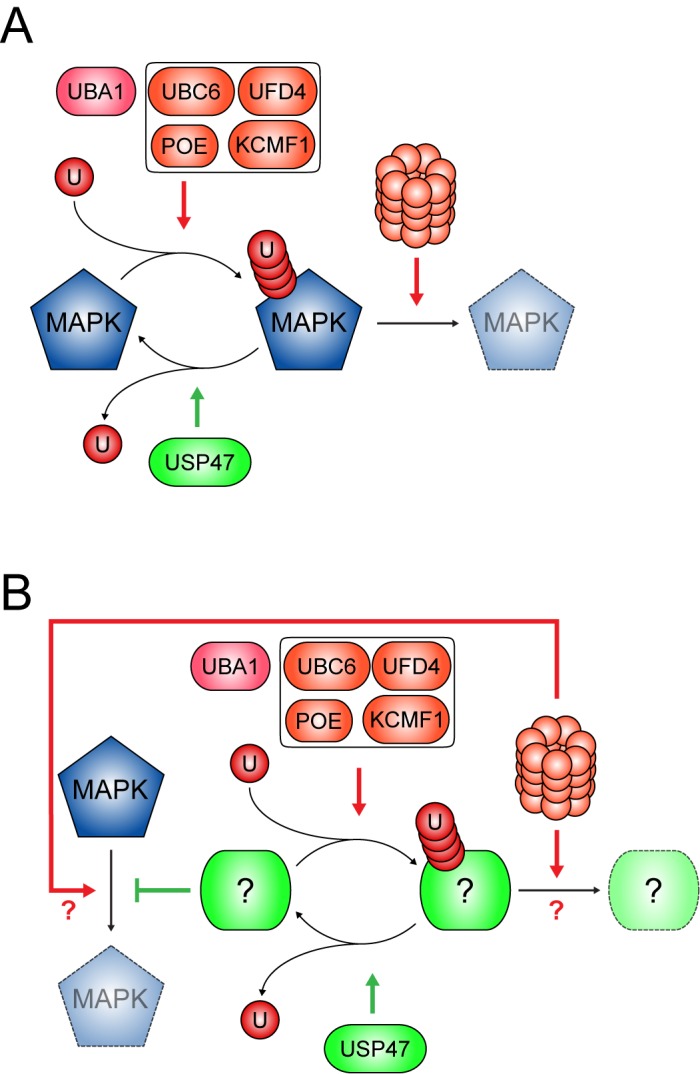
Models for regulation of MAPK stability by USP47.(A) Direct ubiquitination of MAPK. In this model, UBC6, POE, UFD4, and KCMF1 would participate in the direct ubiquitination of MAPK. Ubiquitinated MAPK could then be targeted to the proteasome for degradation. In the presence of USP47, MAPK would be stabilized as USP47 acts to deubiquitinate MAPK, thus counteracting the activity of the ubiquitin ligases. (B) Indirect regulation of MAPK stability. In this alternative model, UBC6, the E3s, and USP47 act on a yet unidentified factor whose proposed role is to stabilize MAPK. In this scenario, the unidentified factor is the direct target of (de)ubiquitination, whereas MAPK is destabilized through ubiquitin-independent means. The unidentified factor may be degraded by the proteasome following its ubiquitination. MAPK might be degraded through a process that does not implicate the proteasome. Alternatively, even though it is not directly ubiquitinated, MAPK might be degraded by the proteasome through ubiquitin-independent degradation. One possibility in this latter case would be that the unidentified factor acts as a chaperone, bringing MAPK to the proteasome. (A,B) Arrow colors are used to indicate positive (green) or negative (red) regulatory impact on MAPK.